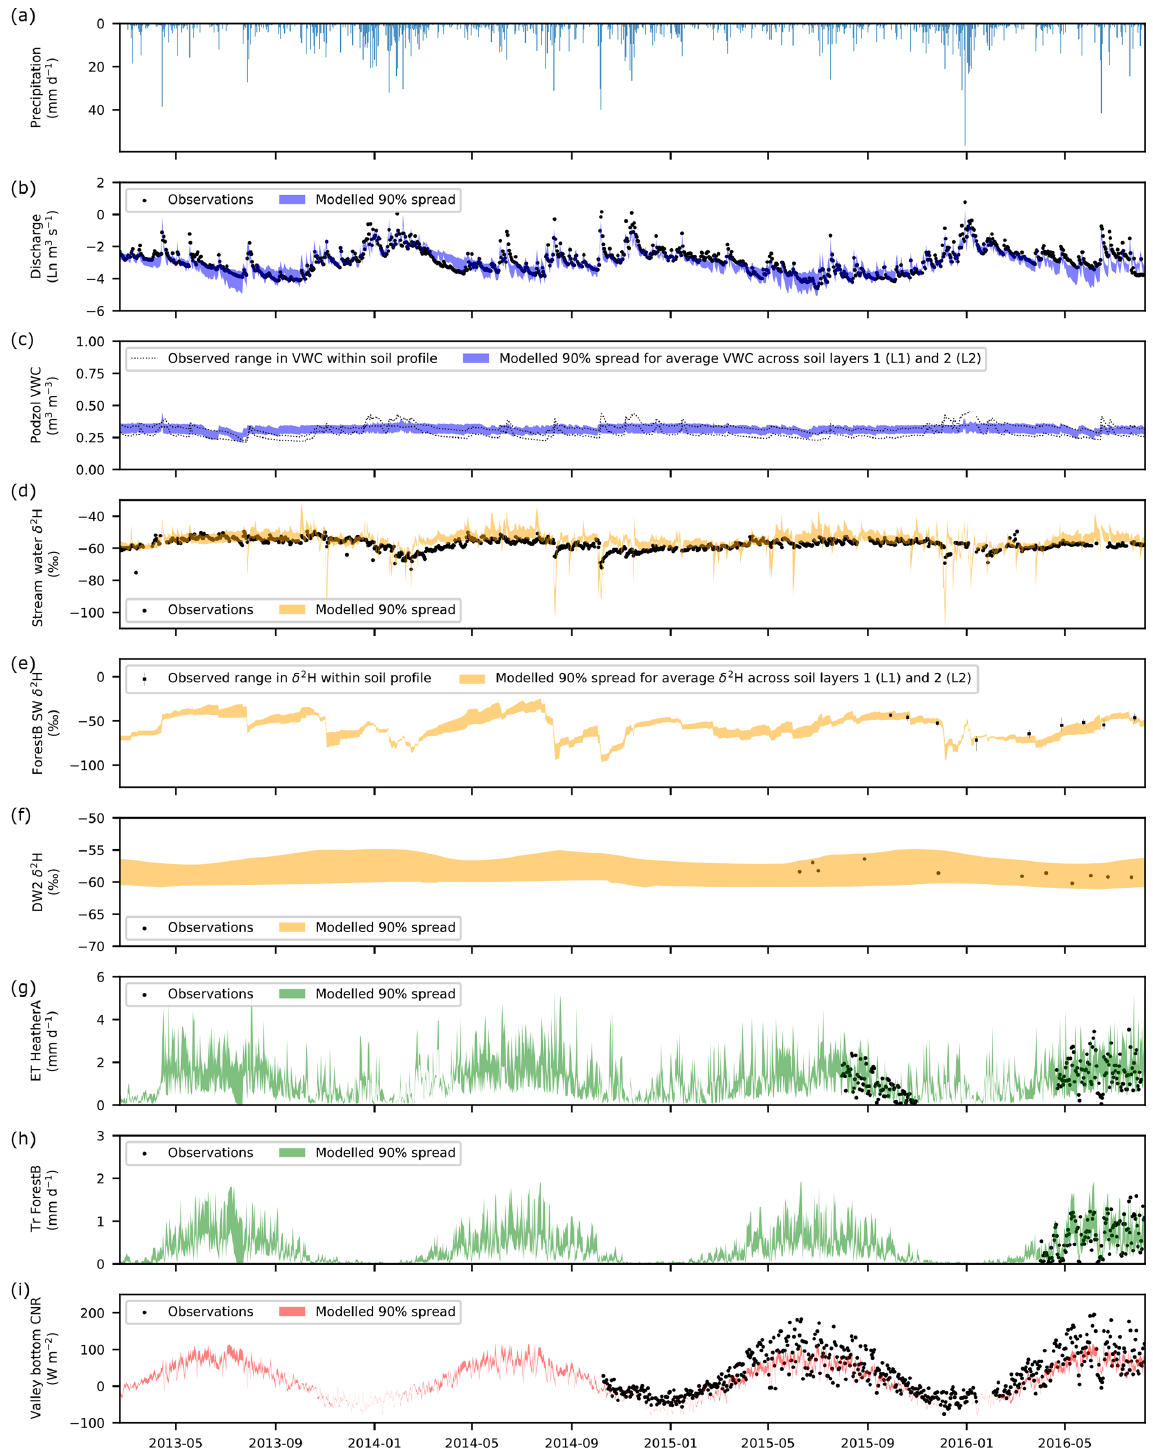
Figure 3. Time series of (a) precipitation and of the observed and simulated (b) natural logarithm (Ln) of stream discharge. (c) Volumetric water content (VWC) at the peaty podzol site. (d) Stream δ 2 H composition. (e) Bulk soil water (SW) δ 2 H under Forest B. (f) Groundwater δ 2 H at deeper well 2 (DW2). (g) Total evapotranspiration (ET) for Heather A. (h) Transpiration (Tr) for Forest B. (i) Net radiation (CNR) at the valley bottom weather station. The 90% spread of simulations are from the 30 behavioural model